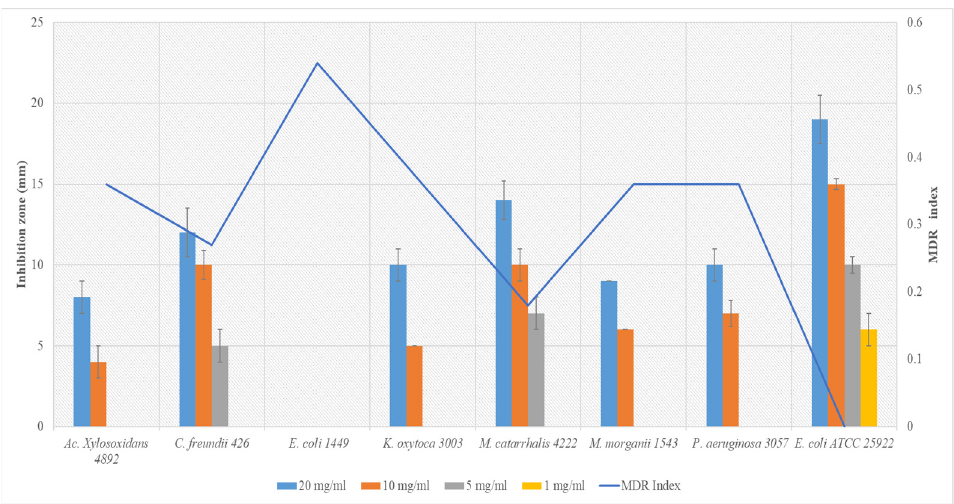
Figure 2. Diameter of the inhibition zone (mm) of A. vera extract against Gram-negative bacteria as a function of concentration and bacterial multidrug drug resistance (MDR) index. Table 3. Susceptibility to antibiotics of the test uropathogenic bacteria.